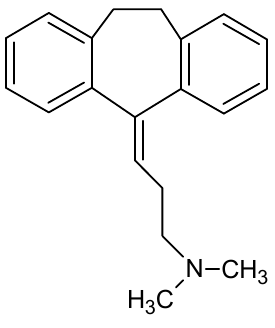
Figure 1. Molecular structure of amitriptyline (AMI).